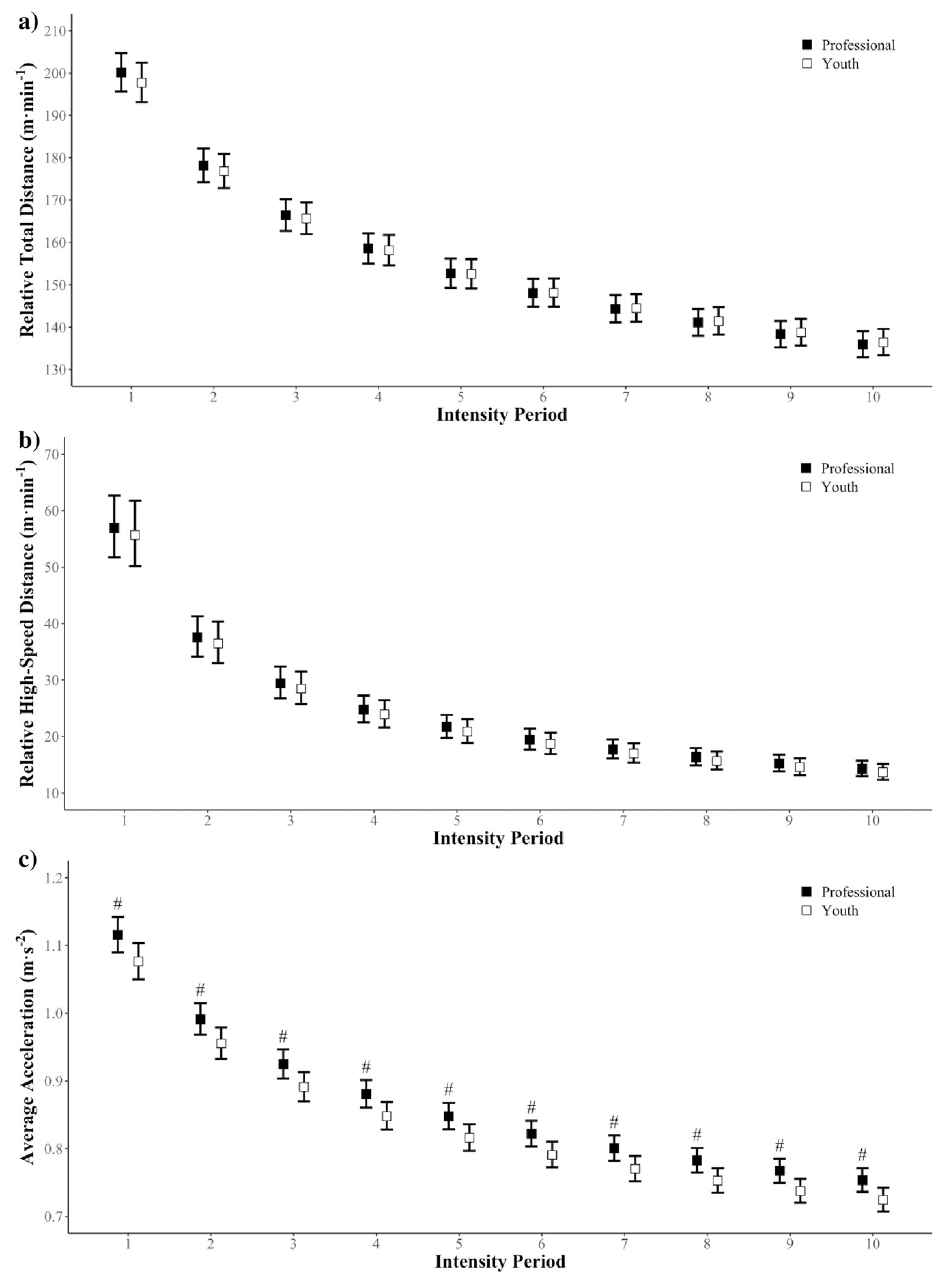
Fig 1. A comparison between youth and professional competitions for peak match running intensities of a) relative total distance, b) relative high-speed distance and c) average acceleration. # = moderate difference to youth (ES = 0.6–